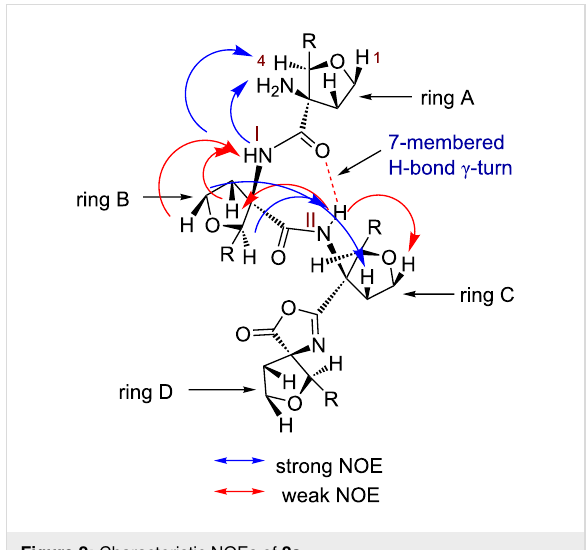
Figure 2: Characteristic NOEs of 2a .